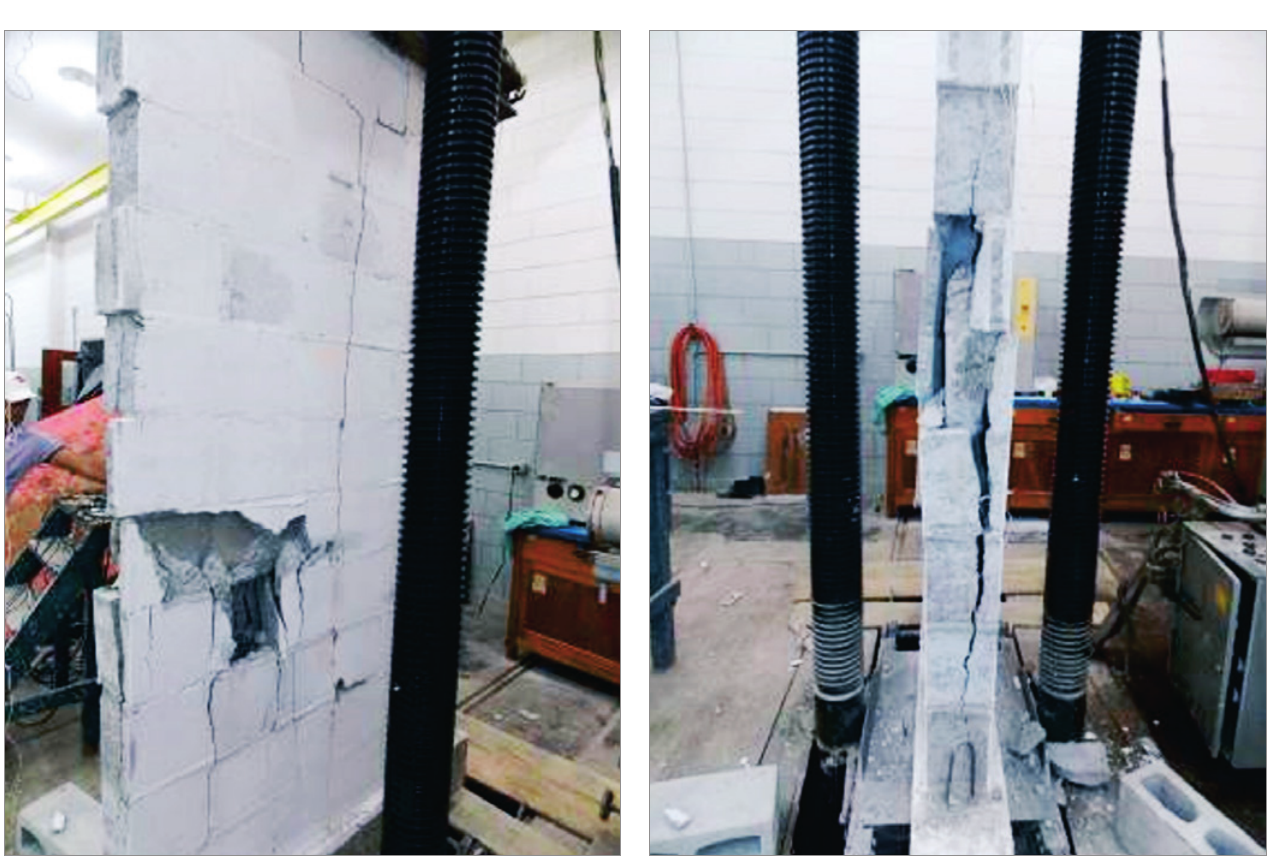
Ilustração da ruptura das paredes